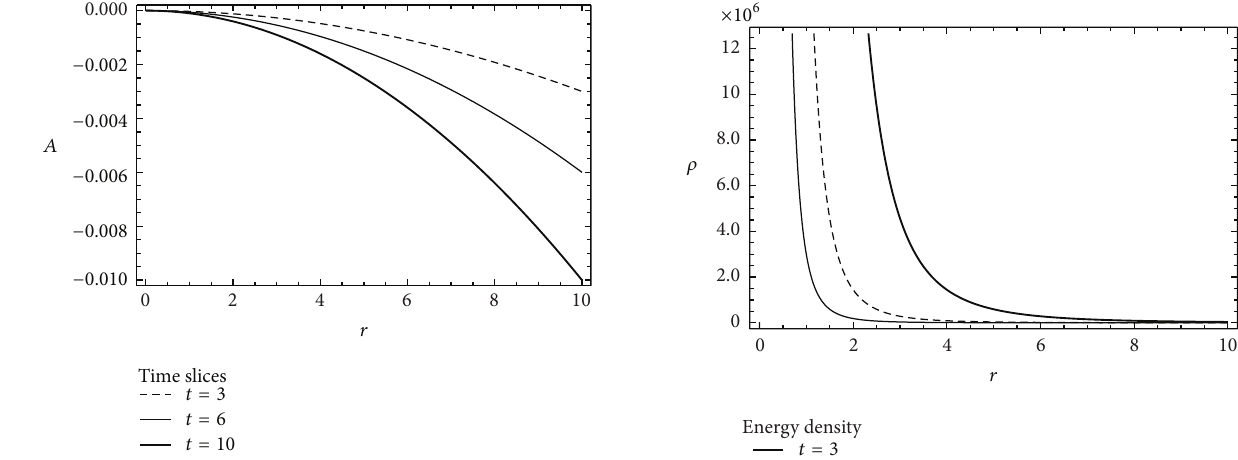
Figure 1: The potential 𝐴 versus 𝑟 at varying units of time.